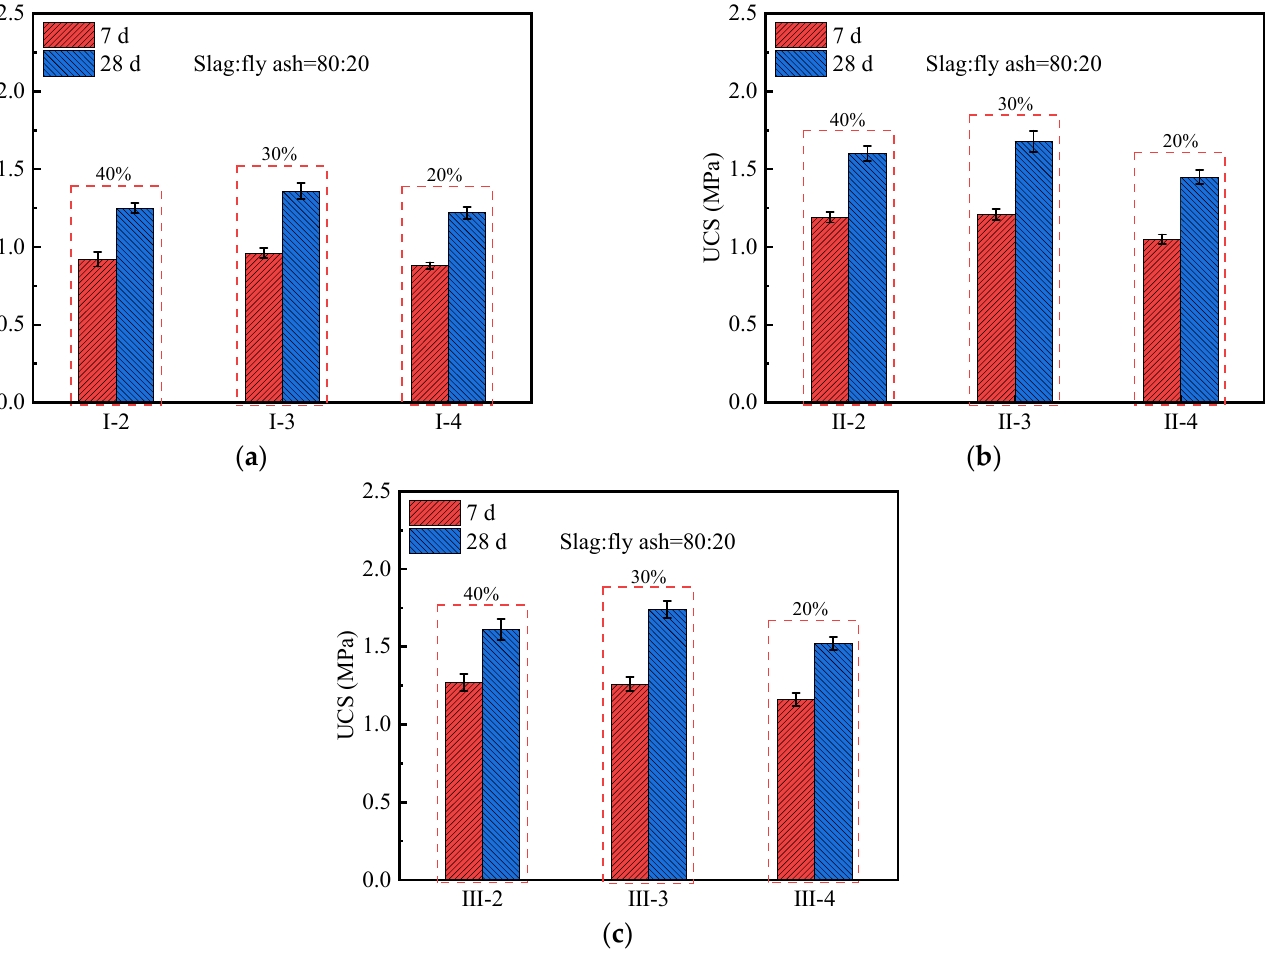
Figure 5. The UCS value of geopolymer stabilized soil with different alkaline activator contents (40%, 30%, and 20%): ( a ) Geopolymer content = 12%; ( b ) Geopolymer content = 15%; ( c ) Geopolymer content = 18%.